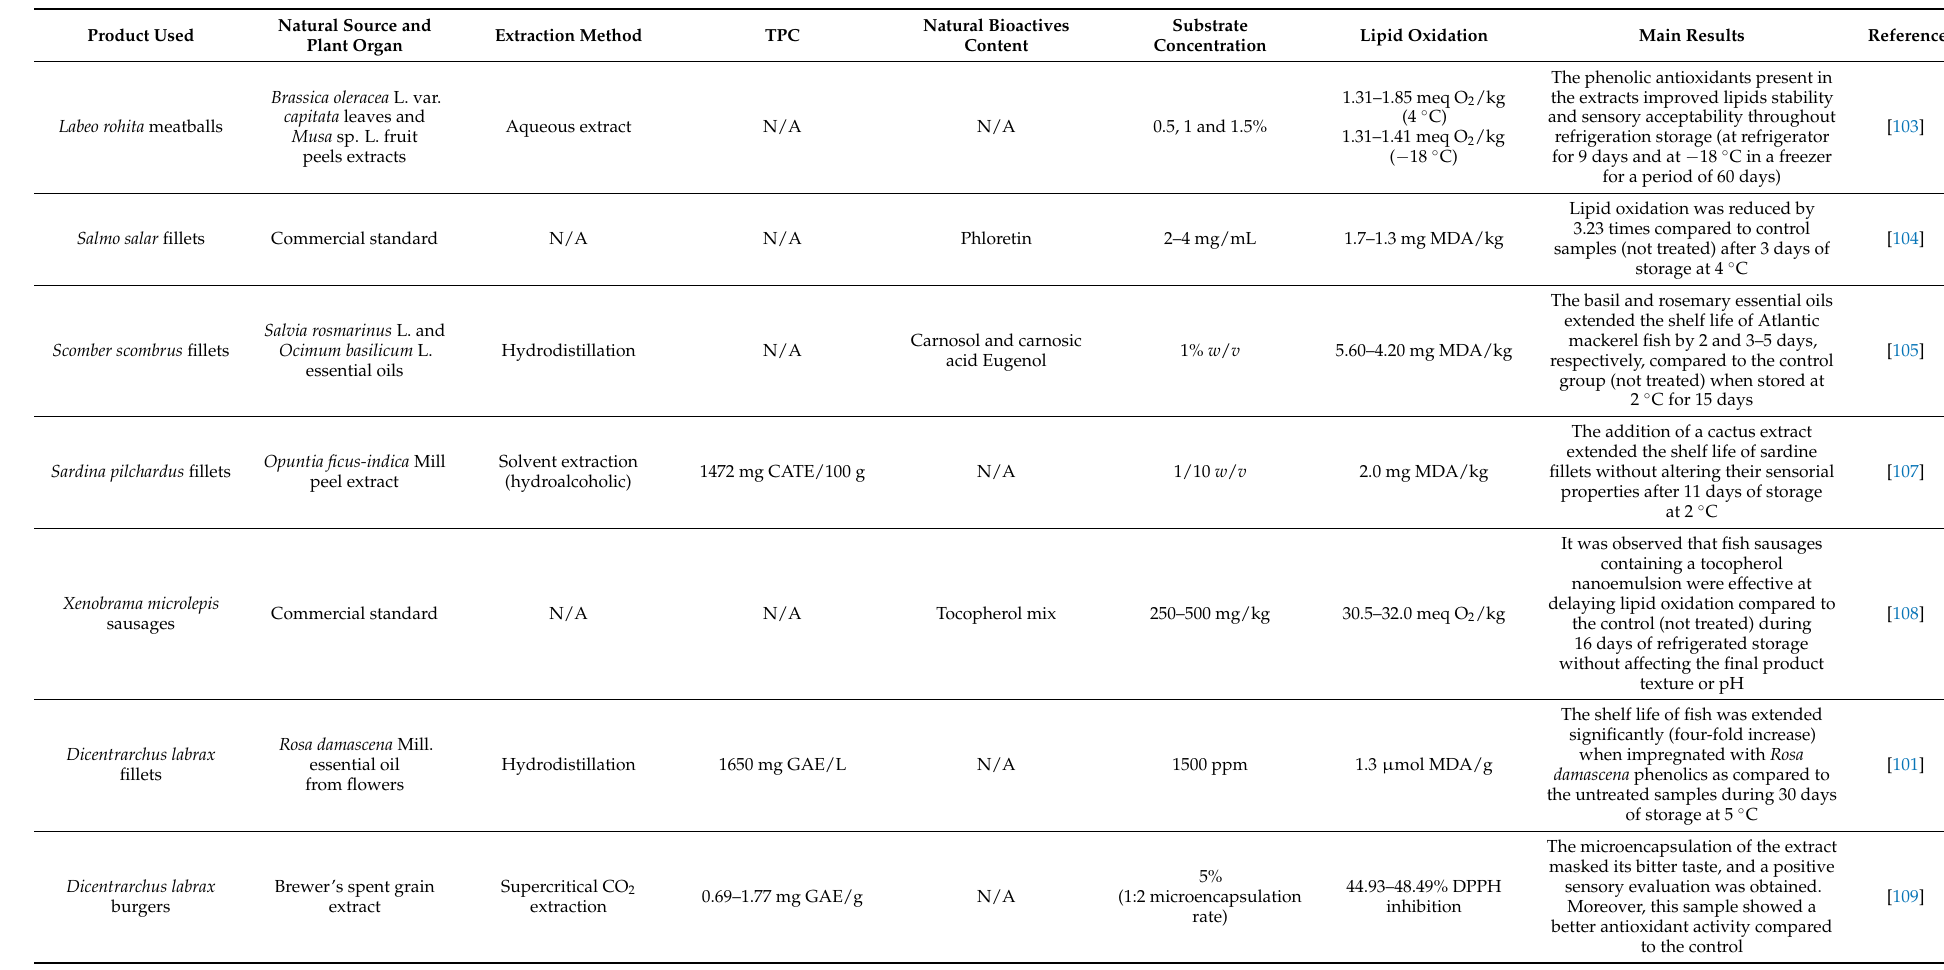
Table 2. Effect of natural antioxidants on lipid oxidative stability of fish food matrices. MDA: malondialdehyde; N/A: not available; GAE: gallic acid equivalent; meq: milliequivalents; CATE: catechin equivalents; LPO: lipid peroxidation; ROS: reactive oxygen species; TPC: total phenolic